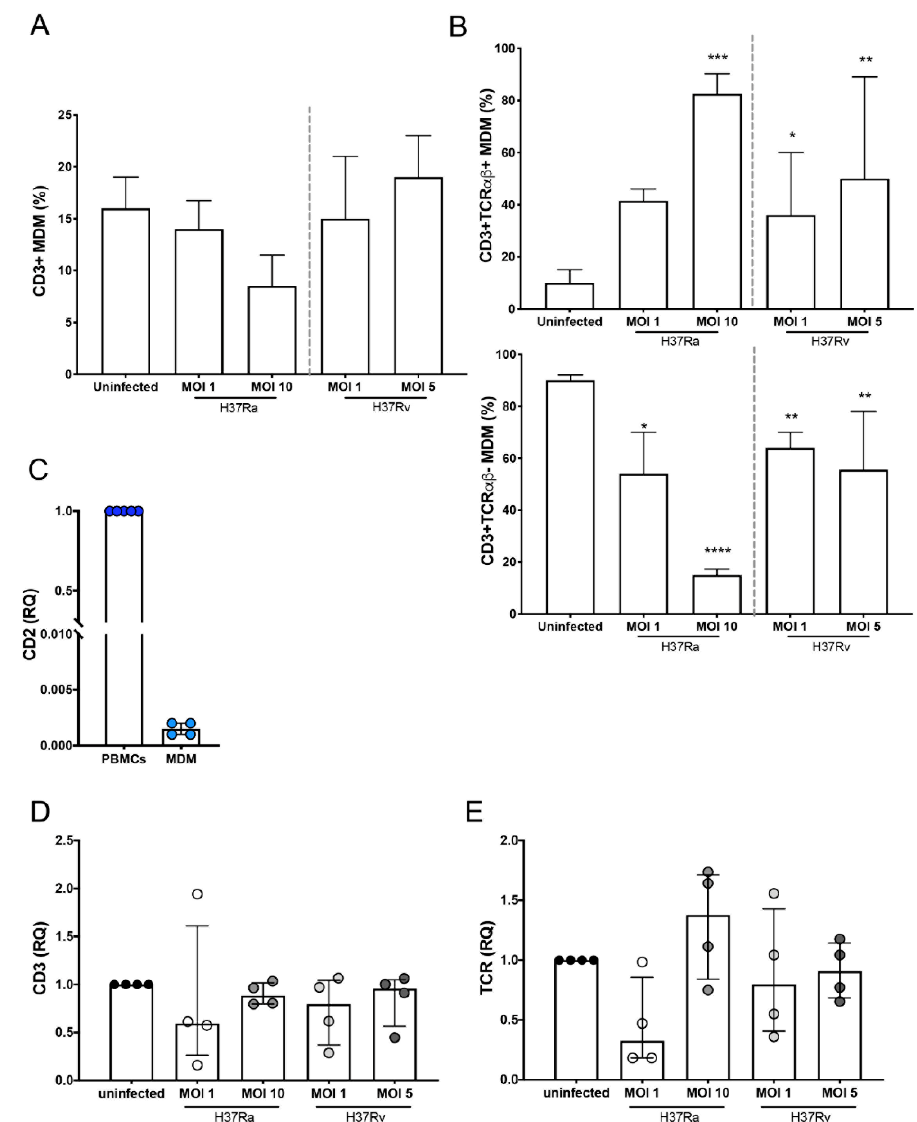
Figure 1. Expression of TCR is increased on the surface of CD3 + monocyte-derived macrophages (MDMs) infected with the Mycobacterium tuberculosis (Mtb) H37Rv virulent strain. Human MDMs were obtained after 7 days in culture; 2 × 10 6 MDMs (per condition) were infected, and at 24 h post- infection, they were recovered. ( A ) Frequency of CD3 + MDMs among macrophages infected with H37Ra (MOI = 1 and 10) and H37Rv (MOI = 1 and 5) Mtb strains; and ( B ) frequency of CD3 + TCRαβ + and CD3 + TCRαβ − subpopulations. The relative expression of CD2 ( C ), CD3 ( D ), and TCR ( E ) genes in Mtb-infected MDMs was assessed by real-time qPCR, and the gene expression was calculated relative to that in the uninfected MDMs for each experimental replicate (RQ = 1). Bar graphs in A and B show median values and interquartile ranges (IQRs, 10 – 90) from four independent experiments; scatter plots with bar in C, D, and E show median values and IQRs from four independent experiments. Statistical analysis was performed with the Kruskal –Wallis test followed by Dunn’s post-test to compare infected versus uninfected MDMs. * p < 0.05, ** p < 0.01, *** p < 0.001, **** p < 0.0001.